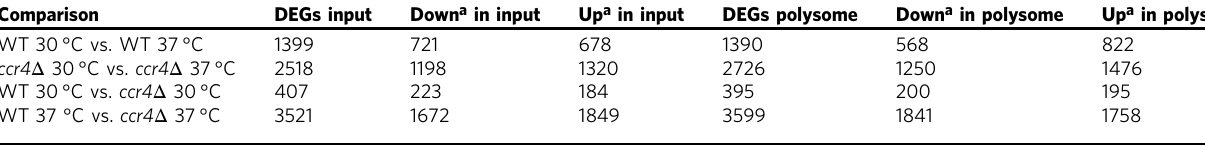
Table 1 Summarized results from RNA-seq analysis Comparison